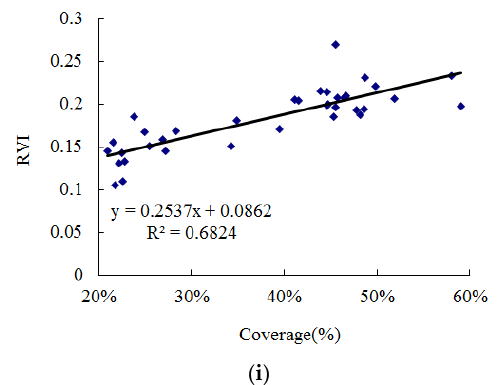
Figure 9. Linear regression analysis between coverage of S. chamaejasme community and feature indexes ( n = 38). ( a – i ) Corresponds to the indexes in Equations (1)–(9).